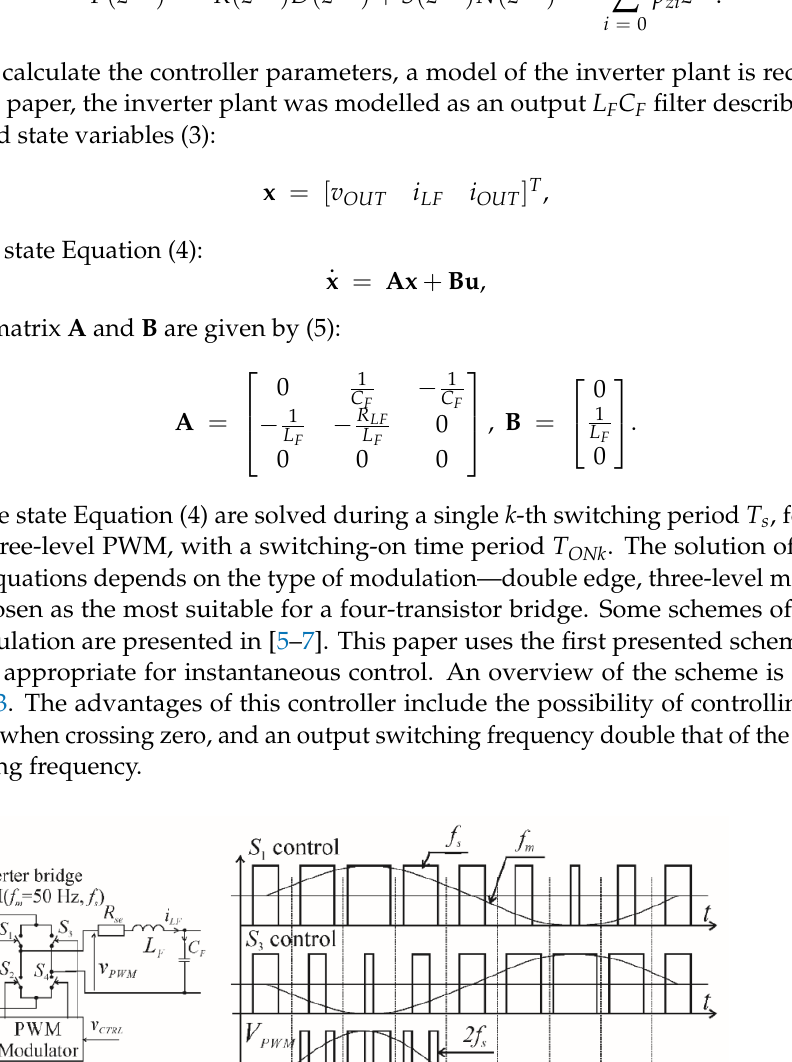
Figure 3. Overview of the first PWM modulation scheme.